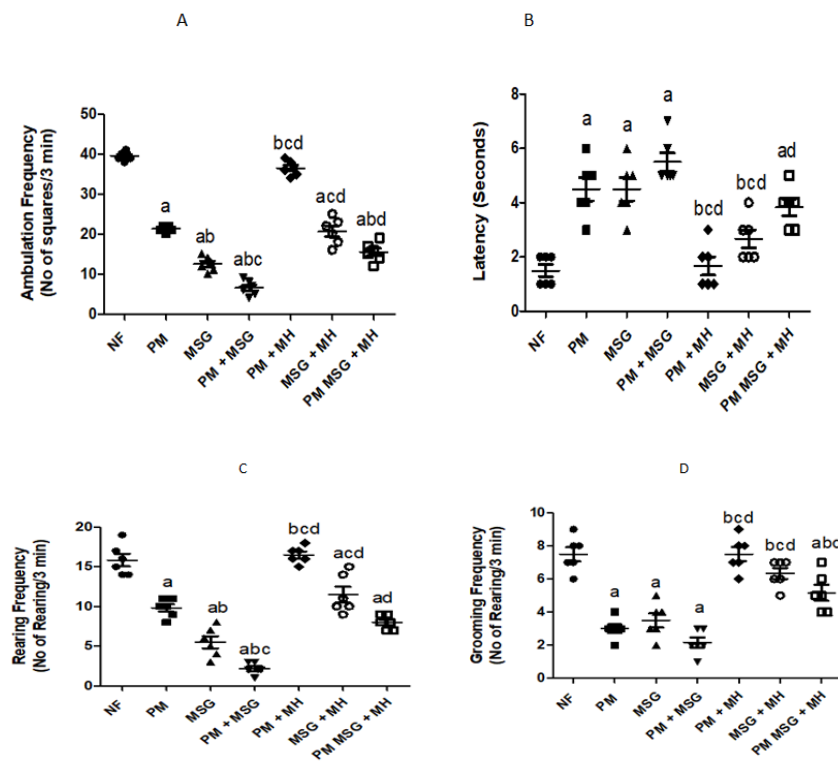
Figure 4. MH restores frequencies in OFT of PM and/or MSG—fed rat pups. Effect of MH (60 mg/kg) on low protein diet (PM) and/or 0.4 g/kg MSG on: ambulation ( A ); latency ( B ); rearing ( C ); and grooming ( D ) frequencies in OFT. Data presented as mean ± SEM ( n = 6). a–d depicts significant difference from NF, PM, MSG, PM + MSG, respectively, at p < 0.05. Statistical analysis was performed using one-way ANOVA followed by Tukey’s post hoc test ( p < 0.05). [The data of the effect of MH on the control NF is not shown as it is not significant].